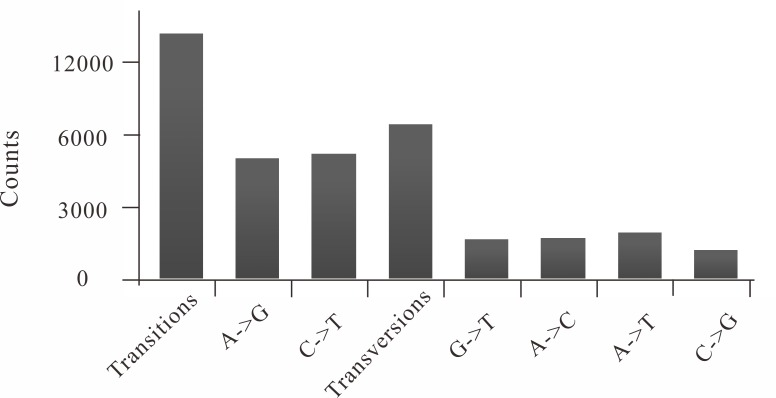
Transitions and transversions occurring within a set of filtered SNPs.